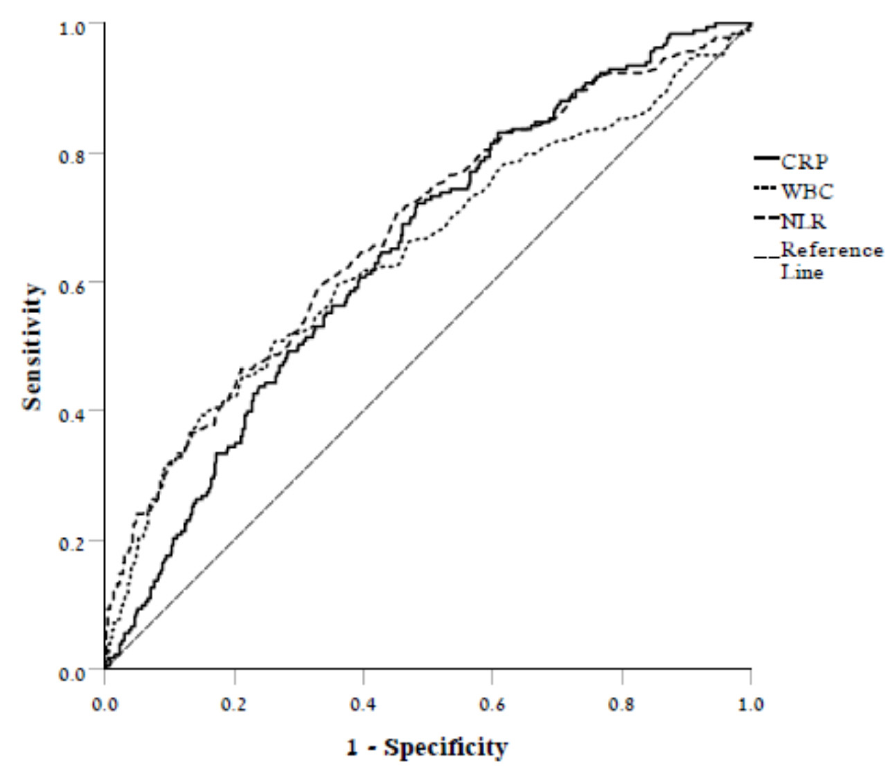
Figure 1. Receiver operating characteristic curve illustrating the ability of CRP, WBC, and NLR to discriminate between those who died and those who survived.